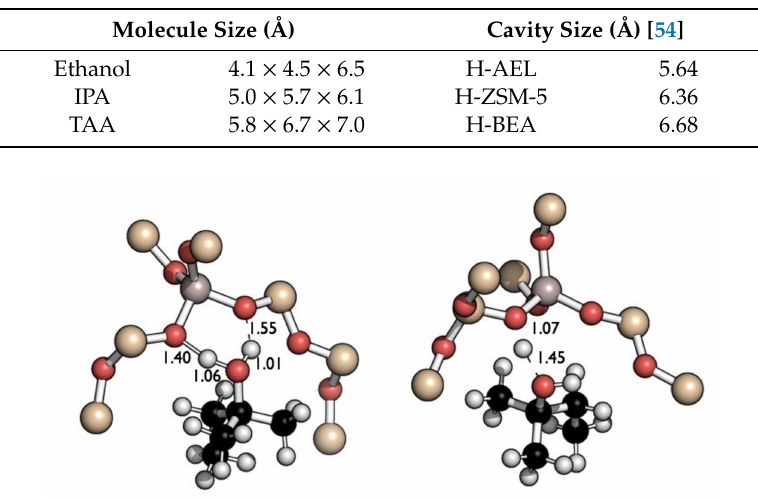
Figure 4. Optimized geometries of TAA in H-ZSM-5 with sinusoidal (left) and straight (right) channels; (black: C atom; white: H atom; red: O atom; brown: Si atom; gray: Al